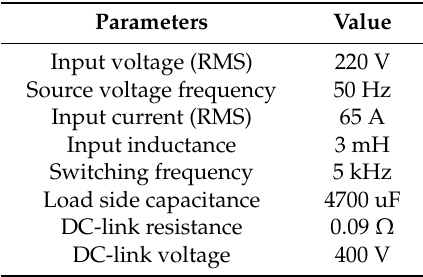
Table 2. Main parameters of the simulation.